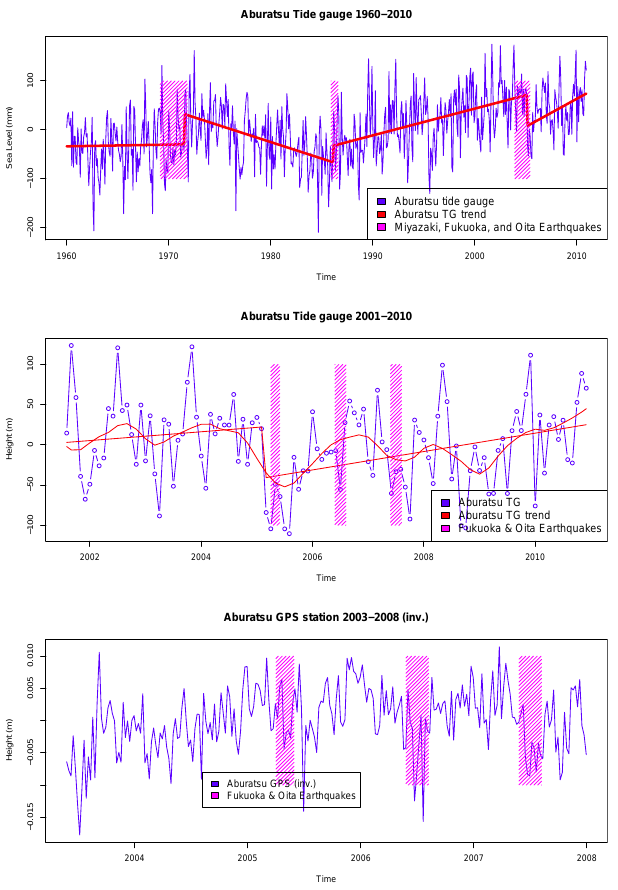
Fig. 14. The impact of earthquakes on Aburatsu tide gauge and co-located GPS station P211 height time series: Aburatsu tide gauge sea level time series (1960–2010, the upper panel), a close-up of the tide gauge time series for 2001–2010 (the middle panel) and inverted height time series at the GPS station P211 (2003–2008, the lower panel). The pink shading marks the interval for possible breakpoints detected by the BFAST algorithm caused by the 2005 Fukuoka earthquakes and the 2006 and 2007 Oita earthquakes.